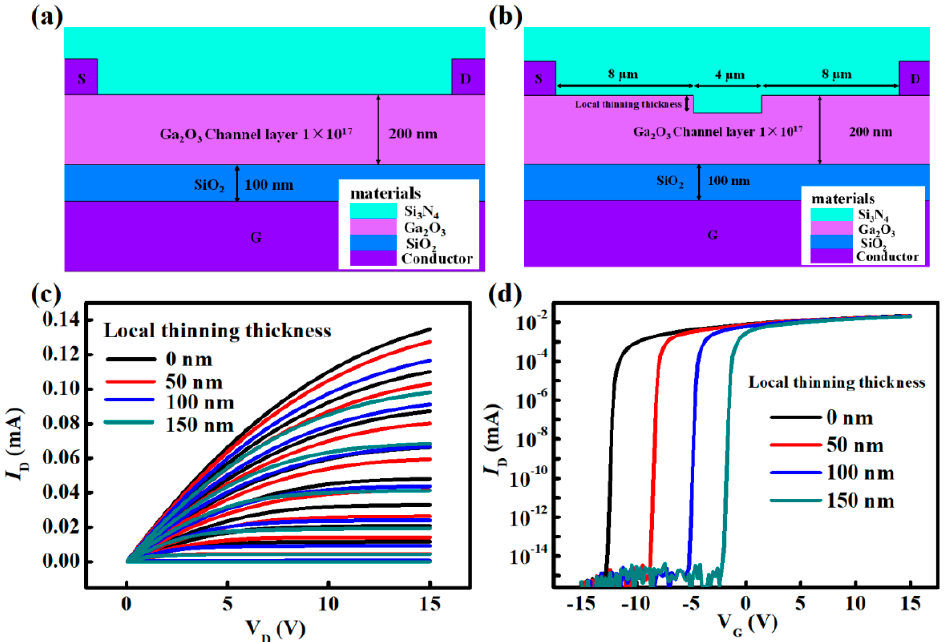
Figure 3. Schematic diagram of the simulation structure of bottom − gate Ga 2 O 3 FET without ( a ) and with ( b ) local thinning, output characteristic curves ( c ) and transfer characteristic curves ( d ) of diiferent local thinning thickness.